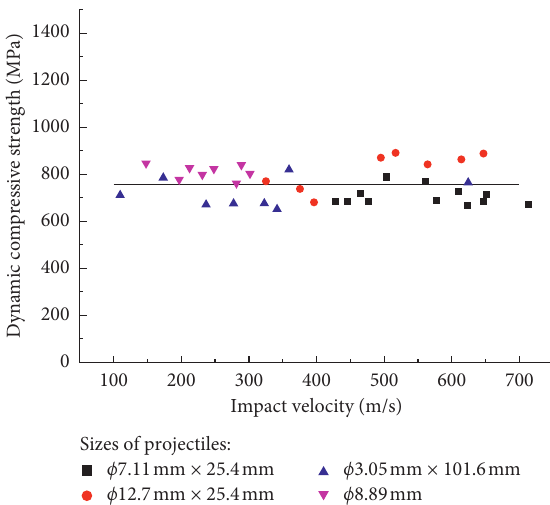
Figure 2: Dynamic compression strength of projectiles at different impact